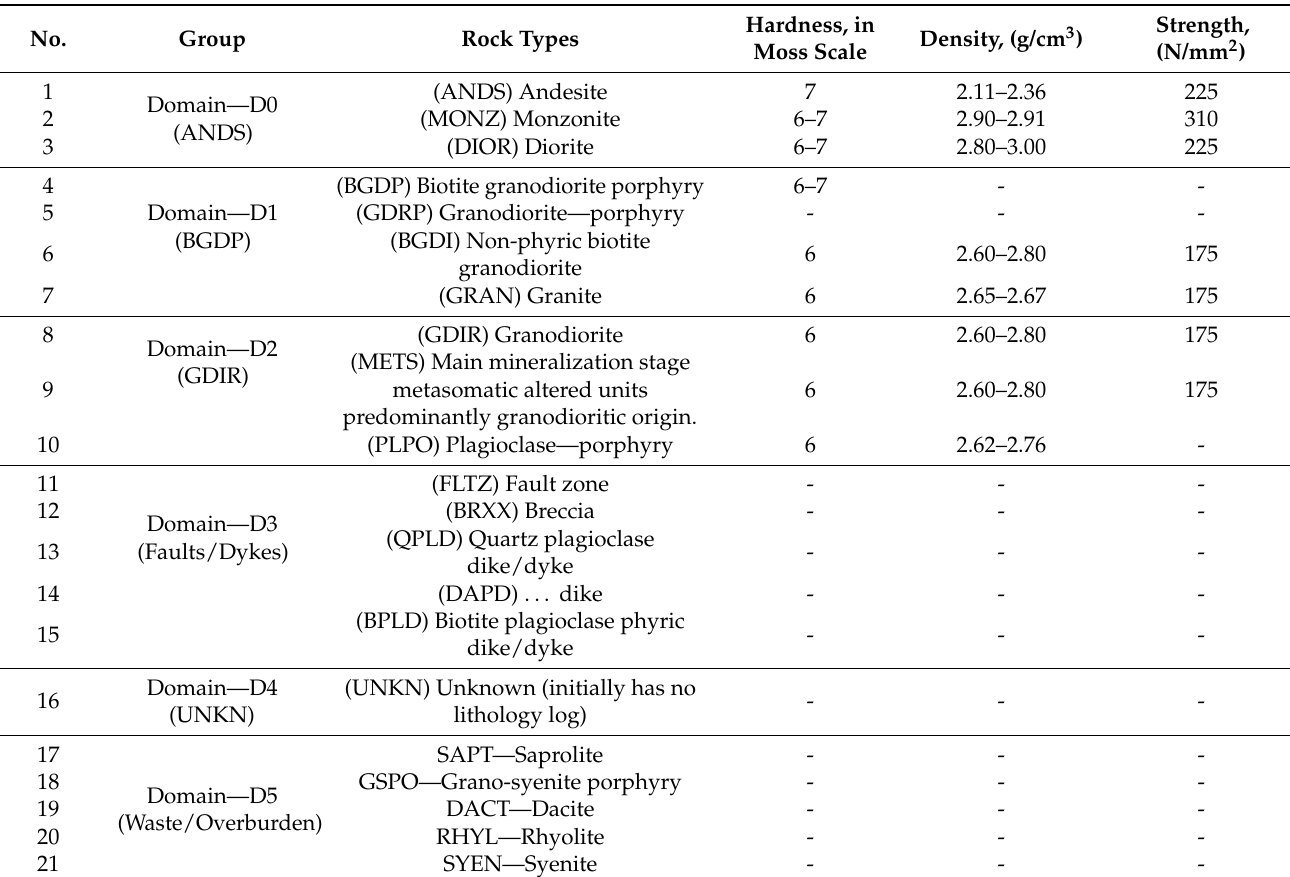
Table 1. The rock domains and their characteristics.